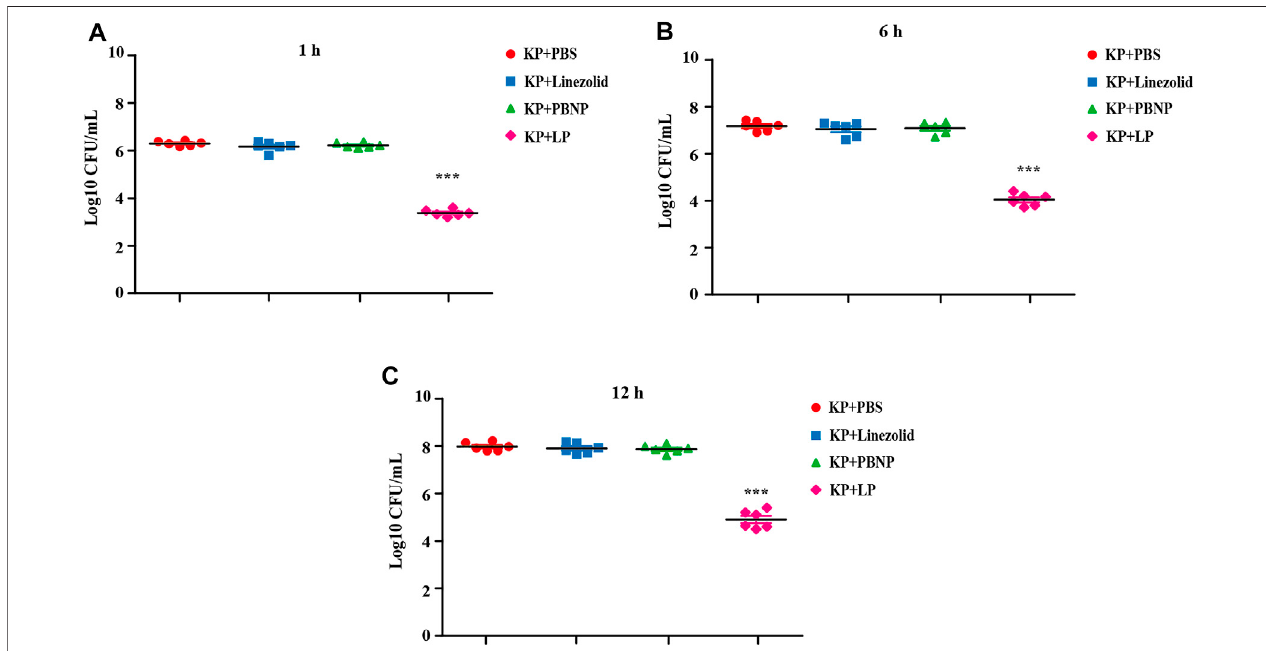
FIGURE 4 | Bacterial burdens in MH-S cell infected with K. pneumoniae (A – C) The MH-S cells were infected with KPWT at an MOI of 10 for 1 h. And then treated withPBS,linezolid(16 μ g/ml),PBNP(8 μ g/ml)orLPfor1 h (A) ,6 h (B) ,and12 h (C) .Thebacteriaburdensweredeterminedasdescribedabove.Dataareshownasthe mean ± SEM of three independent experiments. *** p < 0.001.